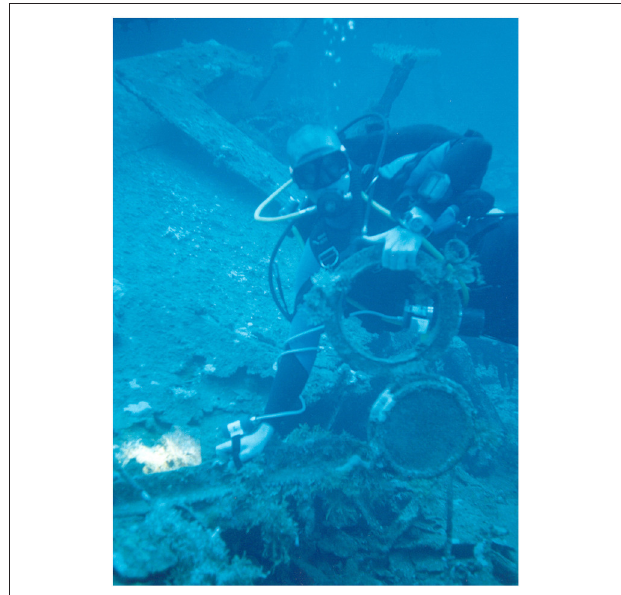
FIGURE 7 | The upside down Yubae Maru wreck undergoing accelerated corrosion due to unrelieved stress in the structure.